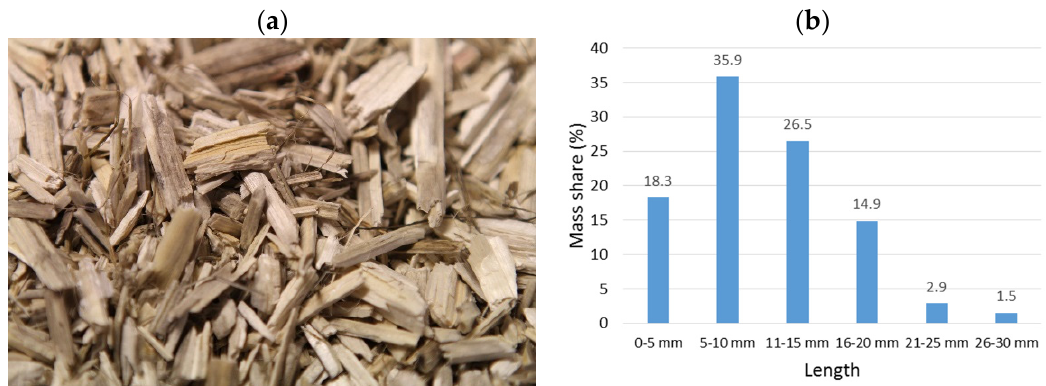
Figure 1. Hemp shives used in investigation ( a ) and their length ( b ).